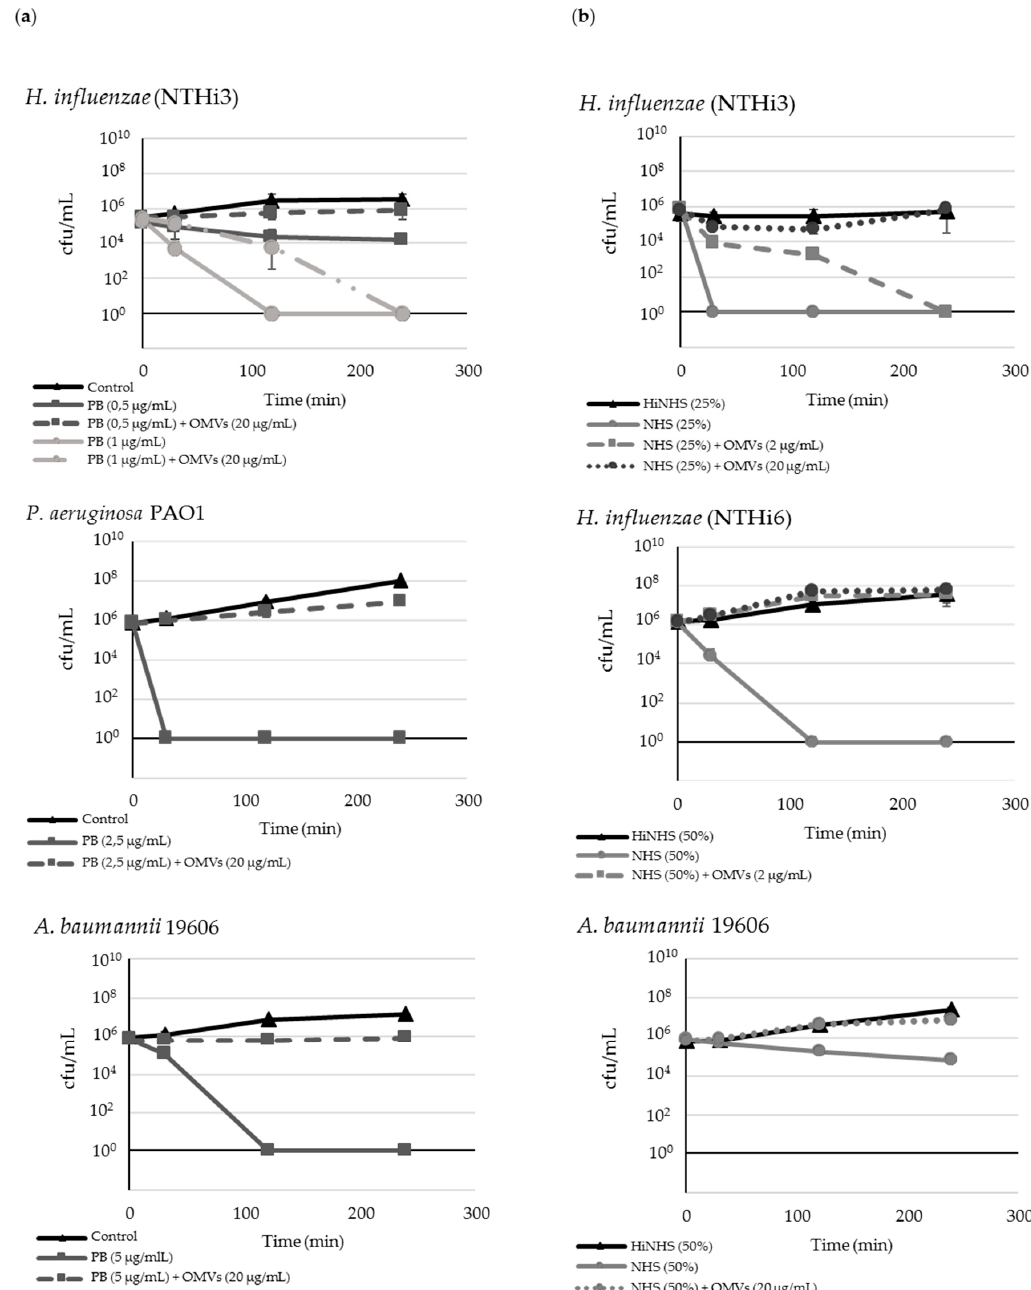
Figure 2. Mc6 OMVs protect bacteria from other species against polymxin B-dependent and human complement-dependent bactericidal activity: ( a ) Polymyxin B-dependent killing; ( b ) human serum (NHS) complement-dependent killing. Bacteria from log phase were incubated for 4 h in the presence of indicated concentrations of membrane-targeting agents alone or along with OMVs and plated in 0, 30, 120, and 240 min. Data are expressed as mean cfu/mL ± SD from three independent experiments performed in triplicate.